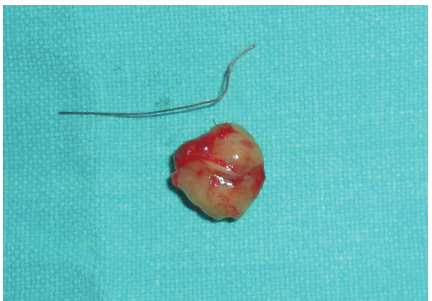
Figure 4: Excised mass.